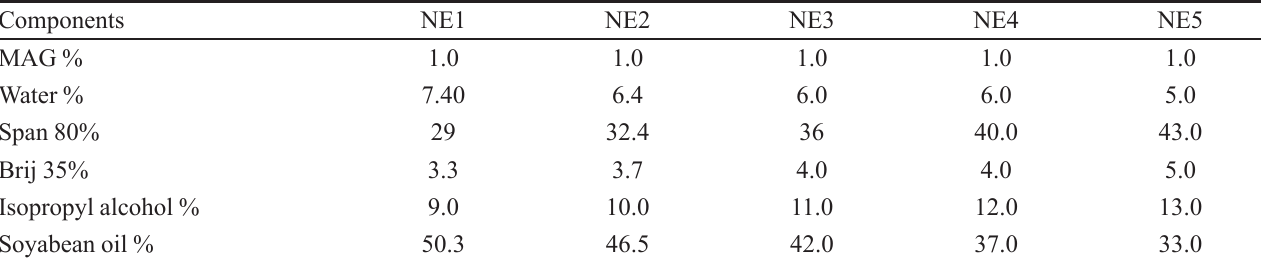
TABLE I - Compositions of the selected nanoemulsion formulations Components